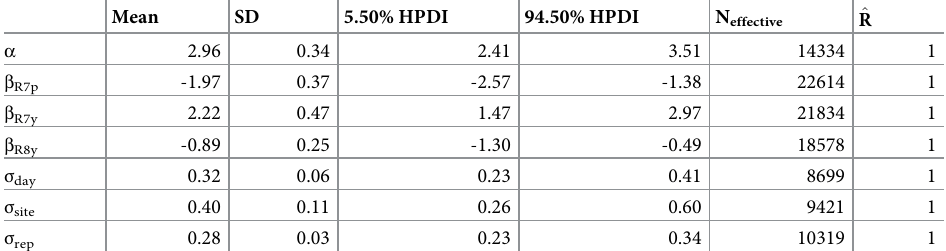
Table 8. A summary of posterior distributions for the coefficients estimated by analysis of new data collected in Kenya, incorporating priors informed by analysis of previously published data [4]. Mean SD 5.50% HPDI 94.50% HPDI N effective ^ R α 2.96 0.34 2.41 3.51 14334 β R7p -1.97 0.37 β R7y 2.22 0.47 1.47 2.97 21834 1 β R8y -0.89 0.25 -1.30 -0.49 18578 1 σ day 0.32 0.06 0.23 0.41 8699 1 σ site 0.40 0.11 0.26 0.60 9421 1 σ rep 0.28 0.03 0.23 0.34 10319 1 SD = standard deviation; HPDI = highest posterior density interval; N effective (= the effective number of samples) and ^ R are convergence and efficiency diagnostics for Markov chains used in model fitting.